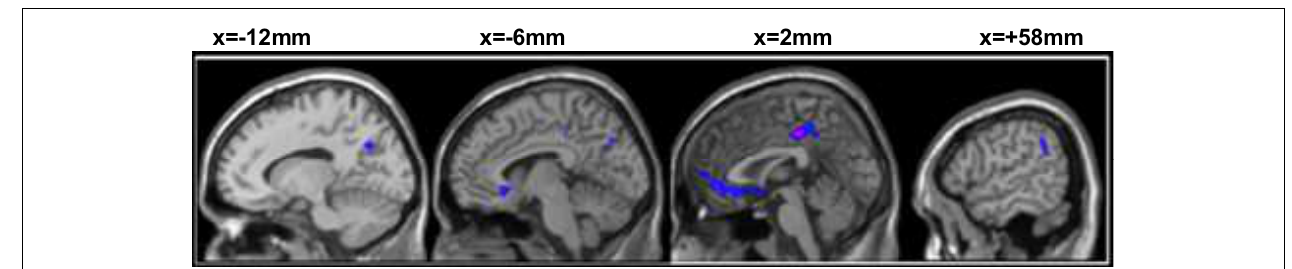
FIGUREA1 | Greater deactivations within the DMN for semantic than perceptual matching (contrast: PM > SM), at p < 0.05 FWE-corrected (magenta) and at p < 0.001 uncorrected (blue). This second-level group analysis was carried out on 71 out of 94 subjects who had positive language laterality indices (LIs assessed within the frontal lobe during the object naming task, see Materials and Methods for more details).The peak coordinates of the five regions of interest from this new analysis were: aPCC (4 − 28 44, z = 5.9); avMPFC (2 46 − 4, z = 5.2); pvMPFC ( − 4 24 − 8, z = 4.9); pPCC ( − 12